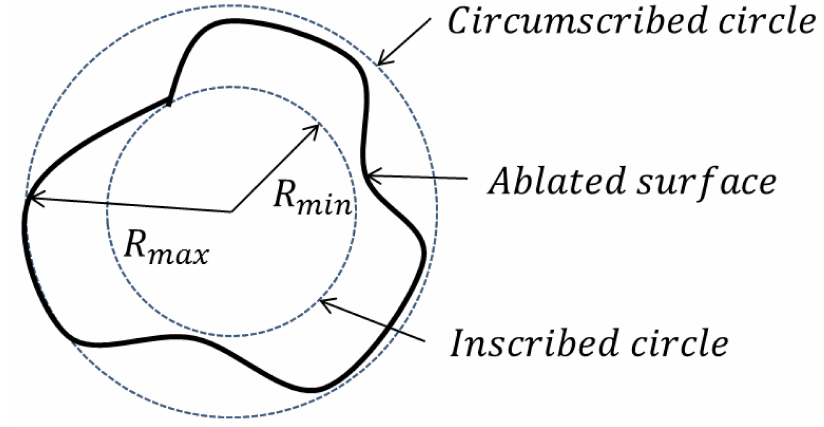
Figure 3. Roundness